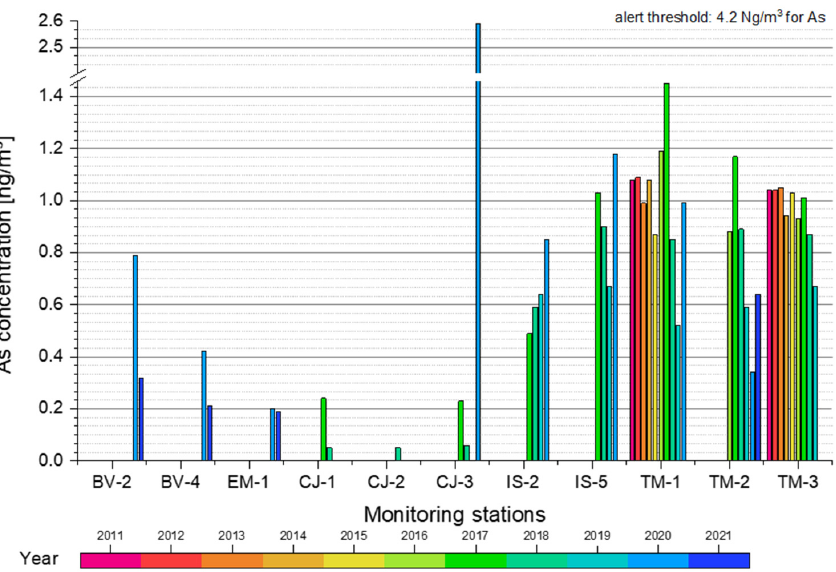
Figure 4. Average annual concentration of As in the four cities (Brasov, Cluj-Napoca, Iasi, and Timisoara).